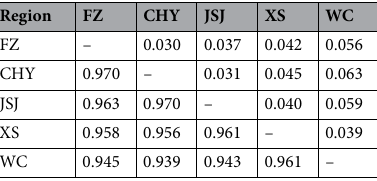
Table 5. Analysis of genetic identity (below diagonal) and genetic distance (above diagonal) among rice in different regions based on Nei’s genetic distance.